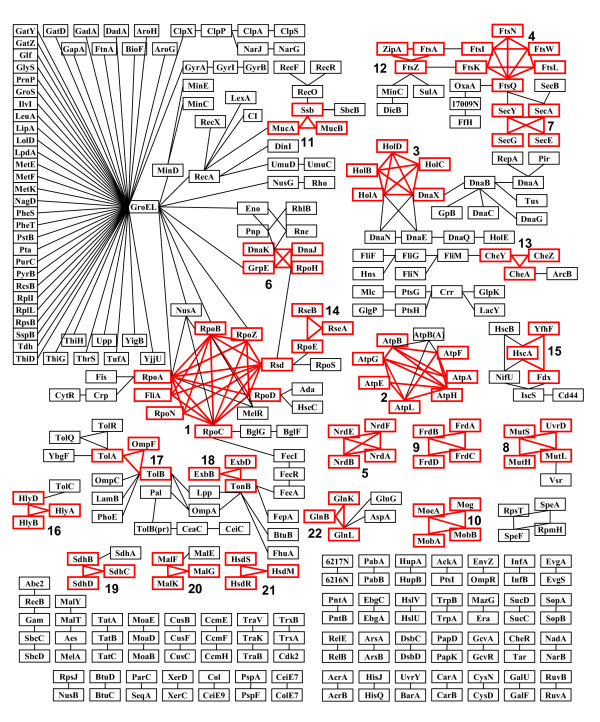
A protein-protein interaction network of E. coli showing high-density complexes of size ≥ 3 detected by the proposed algorithm. Functions of the proteins of 10 largest complexes are as follows: complex 1, components of RNA polymerase (RpoA, RpoB, RpoC, Rsd, RpoZ RpoD, RpoN, FliA); complex 2, components of ATP synthetase (AtpA, AtpB, AtpE, AtpF, AtpG, AtpH, AtpL); complex 3, components of DNA polymerase (DnaX, HolA, HolB, HolD, and HolC); complex 4, proteins involved in cell division (FtsQ, FtsI, FtsW, FtsN, FtsK and FtsL); complex 5, components of ribonucleoside-diphosphate reductase (NrdA, NrdB, NrdE, NrdF); complex 6, chaperons (DnaK, GrpE, DnaI) and a heat-shock sigma factor (RpoH), complex 7, component of protein translocase (SecA, SecE, SecY, SecG); complex 8, DNA mismatch repair proteins (MutL, MutS, MutH, UvrD); complex 9, components of fumarate reductase (FrdA, FrdB, FrdC, FrdD); and complex 10, proteins associated with molybdopterin biosynthesis (MoeA, MoeB, MobB, Mog). 11 to 22 are 3-protein complexes, which mostly consist of similar function proteins.